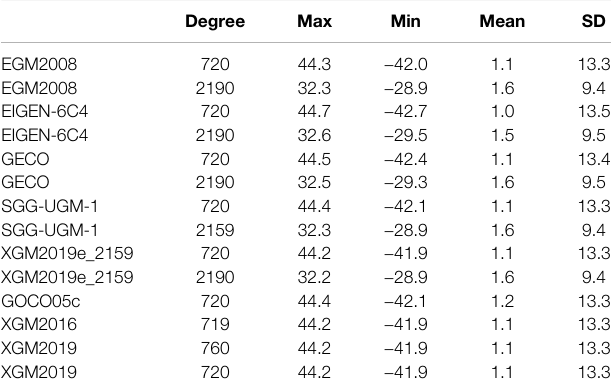
TABLE 3 | Statistics of the differences between the shipborne gravity anomalies retrieved from NGDC and quantities synthesized from different GGMs over South China